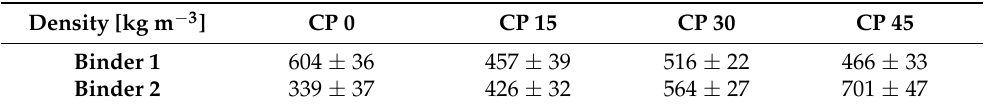
Table 5. Density values of the compression prim samples for both binder systems at the light